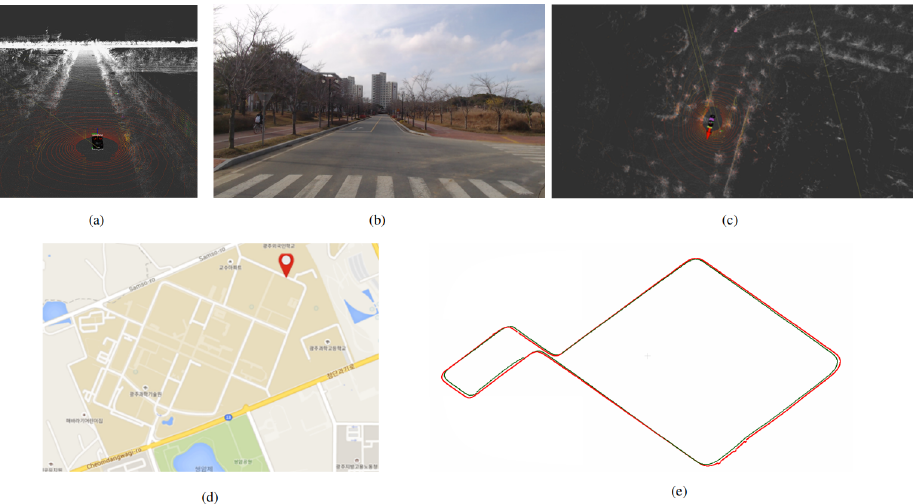
Figure 6. ( a ) The 3D map of the environment formed using the NDT mapping. ( b ) The localization of autonomous vehicle using NDT matching in the 3D map by matching the current Lidar scan and the 3D map information. ( c ) The current view of the environment in image data. ( d ) The current localization is marked in the Google map. ( e ) Qualitative comparison between GNSS pose and NDT pose. The GNSS pose is shown in red and NDT pose is shown in green (Best viewed in